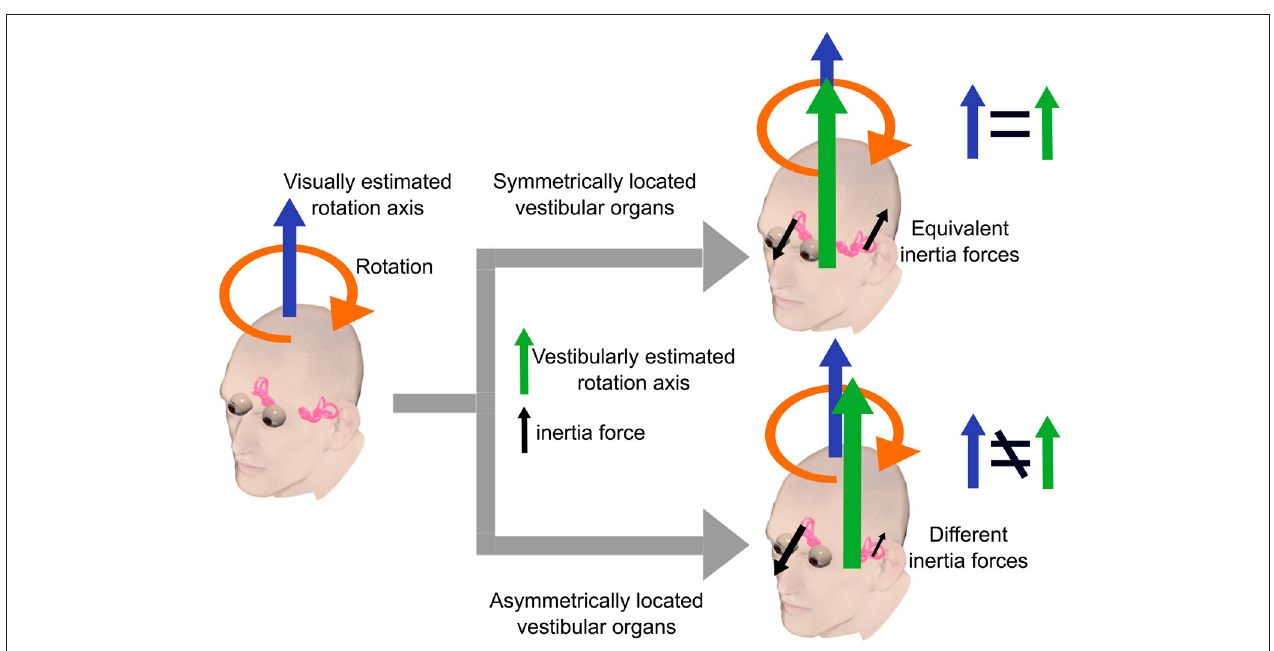
FIGURE 6 | A simple example illustrating our hypothesis. The head rotates around an axis within the sagittal plane equidistant from both eyes. In this case, the visually estimated rotation axis lies in the sagittal plane. The vestibularly estimated rotation axis lies in the sagittal plane when the bilateral vestibular organs are symmetrically located with respect to the sagittal plane. In contrast, vestibularly estimated axis lies outside the sagittal plane when the vestibular organs are asymmetrically located due to unbalanced centrifugal forces on the bilateral vestibular